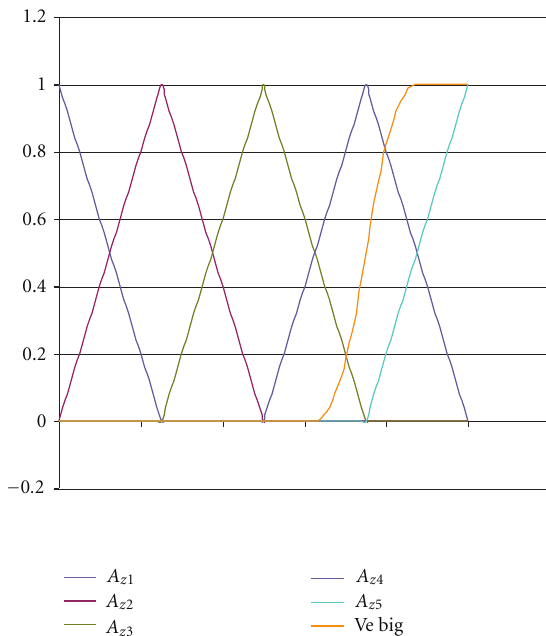
Figure 11: Basic functions used for the residential buildings dataset.